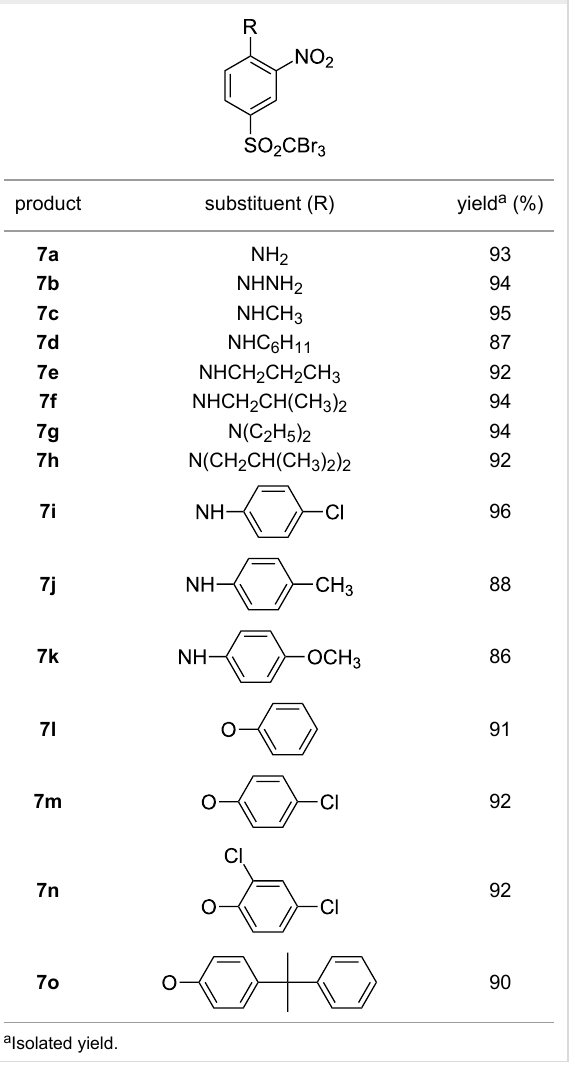
Table 1: Derivatives of 2-nitroaniline, 2-nitrophenylhydrazine and diphenyl